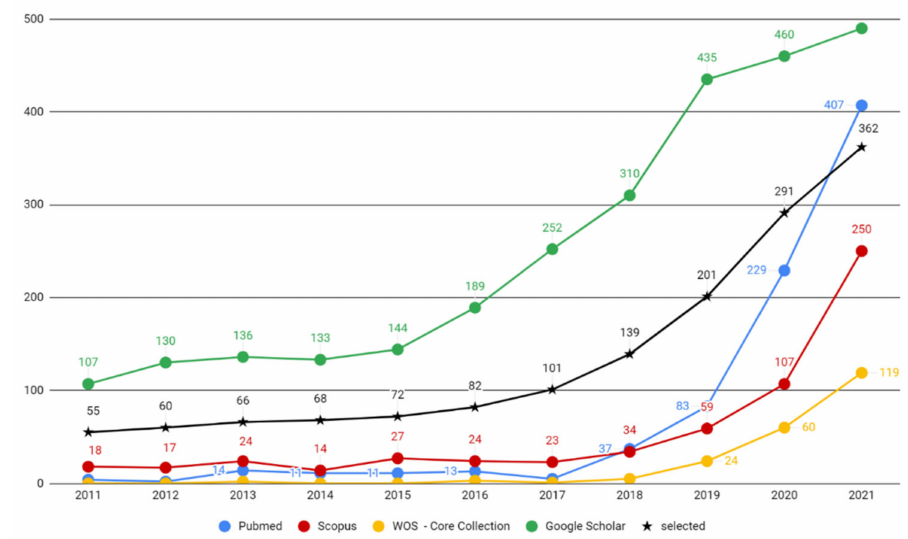
Figure 4. Annual counts of AI-focused dental publications (2011–2021).